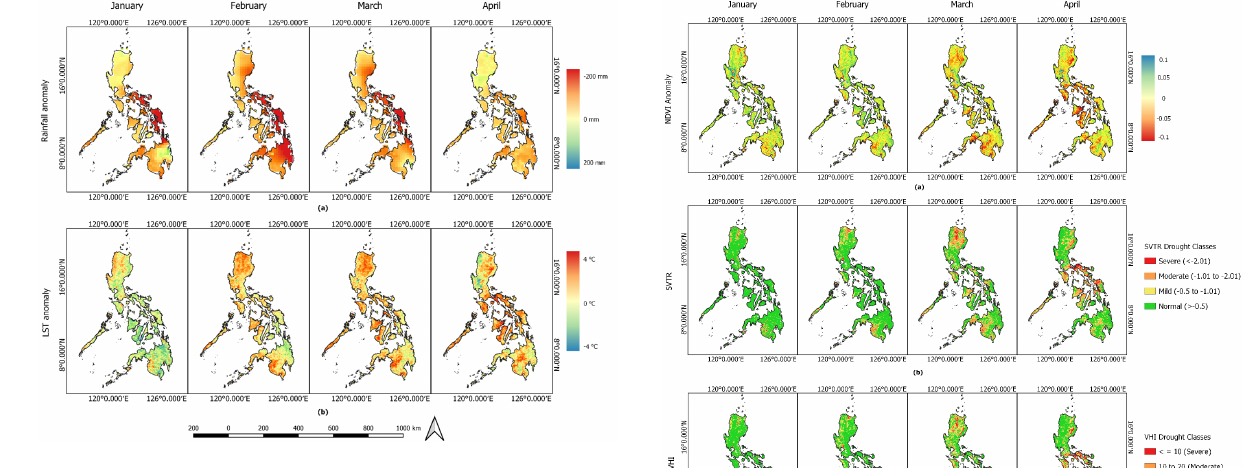
Figure 2. Monthly rainfall anomalies and the monthly land surface temperature anomalies derived from TRMM and MODIS, respectively.